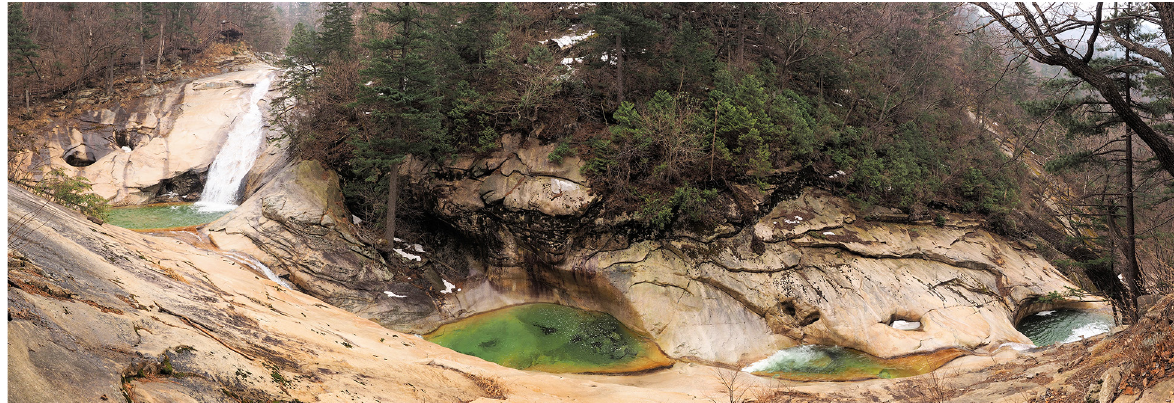
Fig. 6. Bedrock channels, waterfalls and potholes in Sibiseonnyeotang, western Seoraksan (Photo M.